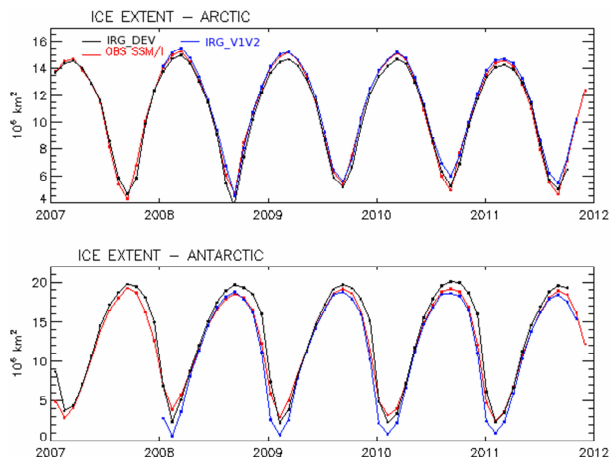
Fig. 11. Sea ice concentration (%) in the Arctic in October 2010: (a) Fig. 11. Sea-ice concentration (%) in the Arctic in October 2010: (a) from CERSAT satellite 1 from CERSAT satellite measurements, (b) from IRG V1V2, and (c) measurements, (b) from IRG_V1V2, (c) from IRG_DEV. Sea-ice drift (m s -1 ) in the Arctic in 2 from IRG DEV. Sea ice drift (ms − 1 ) in the Arctic in October 2010: October 2010: (d) from CERSAT satellite measurements; (e) from IRG_V1V2. 3 (d) from CERSAT satellite measurements and (e) from IRG V1V2.